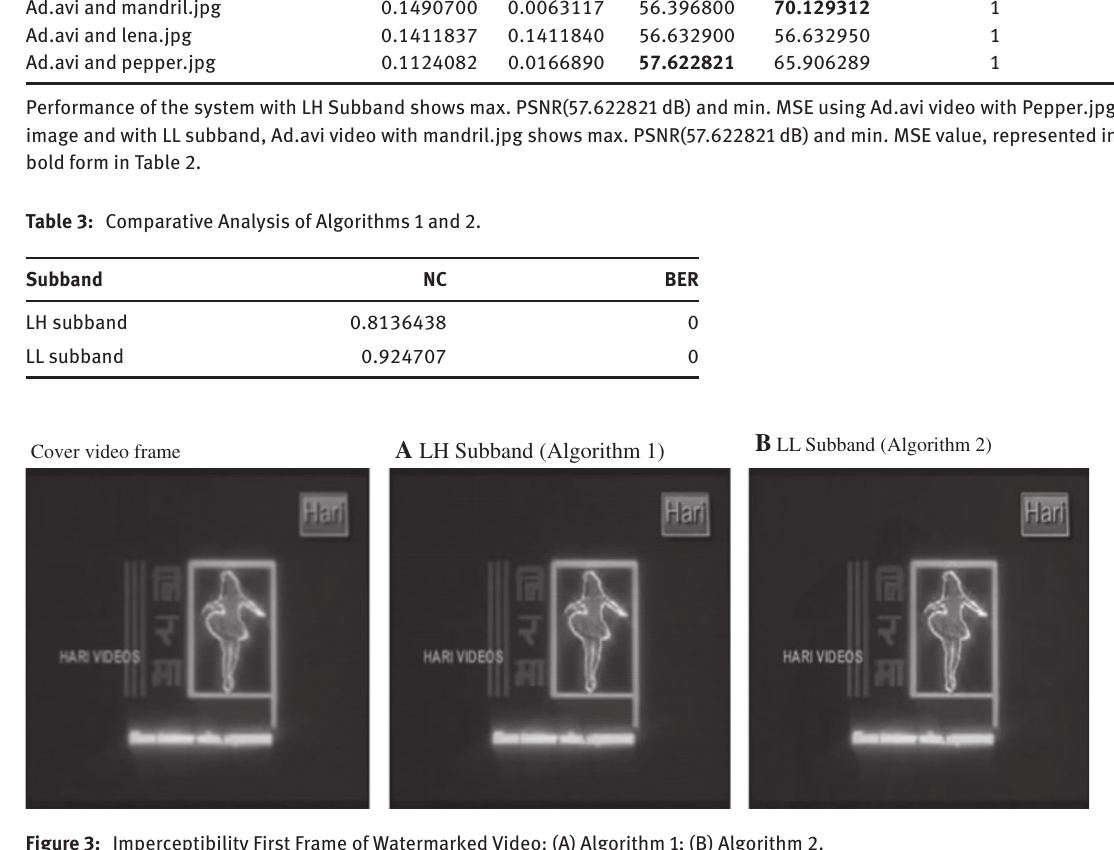
Figure 3: Imperceptibility First Frame of Watermarked Video: (A) Algorithm 1; (B) Algorithm 2.